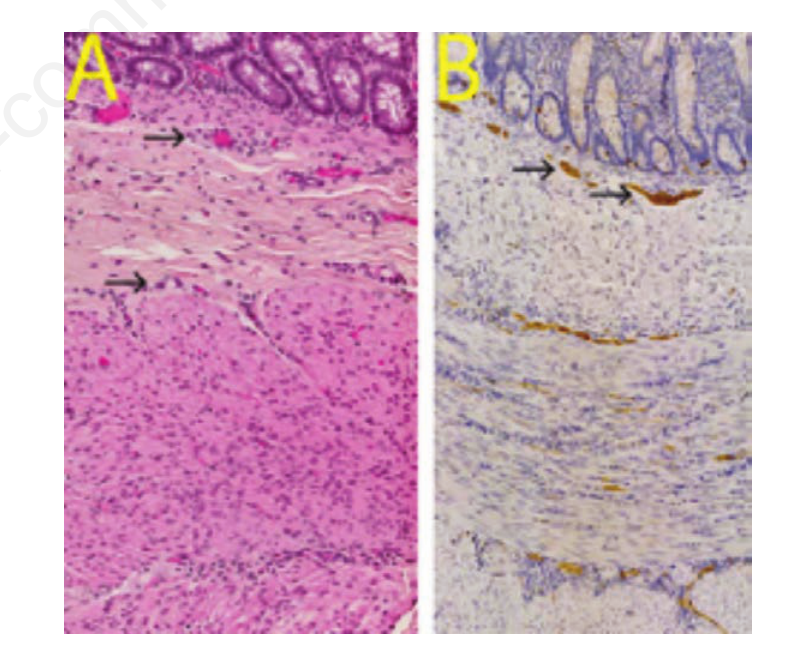
Figure 2. A-B) The pathological findings of resected specimen at the proximal sigmoid colon (the thin arrows are submucosal ganglion cells, and the thick arrows are myenteric ganglion cells). There are both submucosal and myenteric ganglion cells (A: Hematoxylin & eosin stain, magnification: 4×. B: Synaptophysin stain, magnification: 4×).